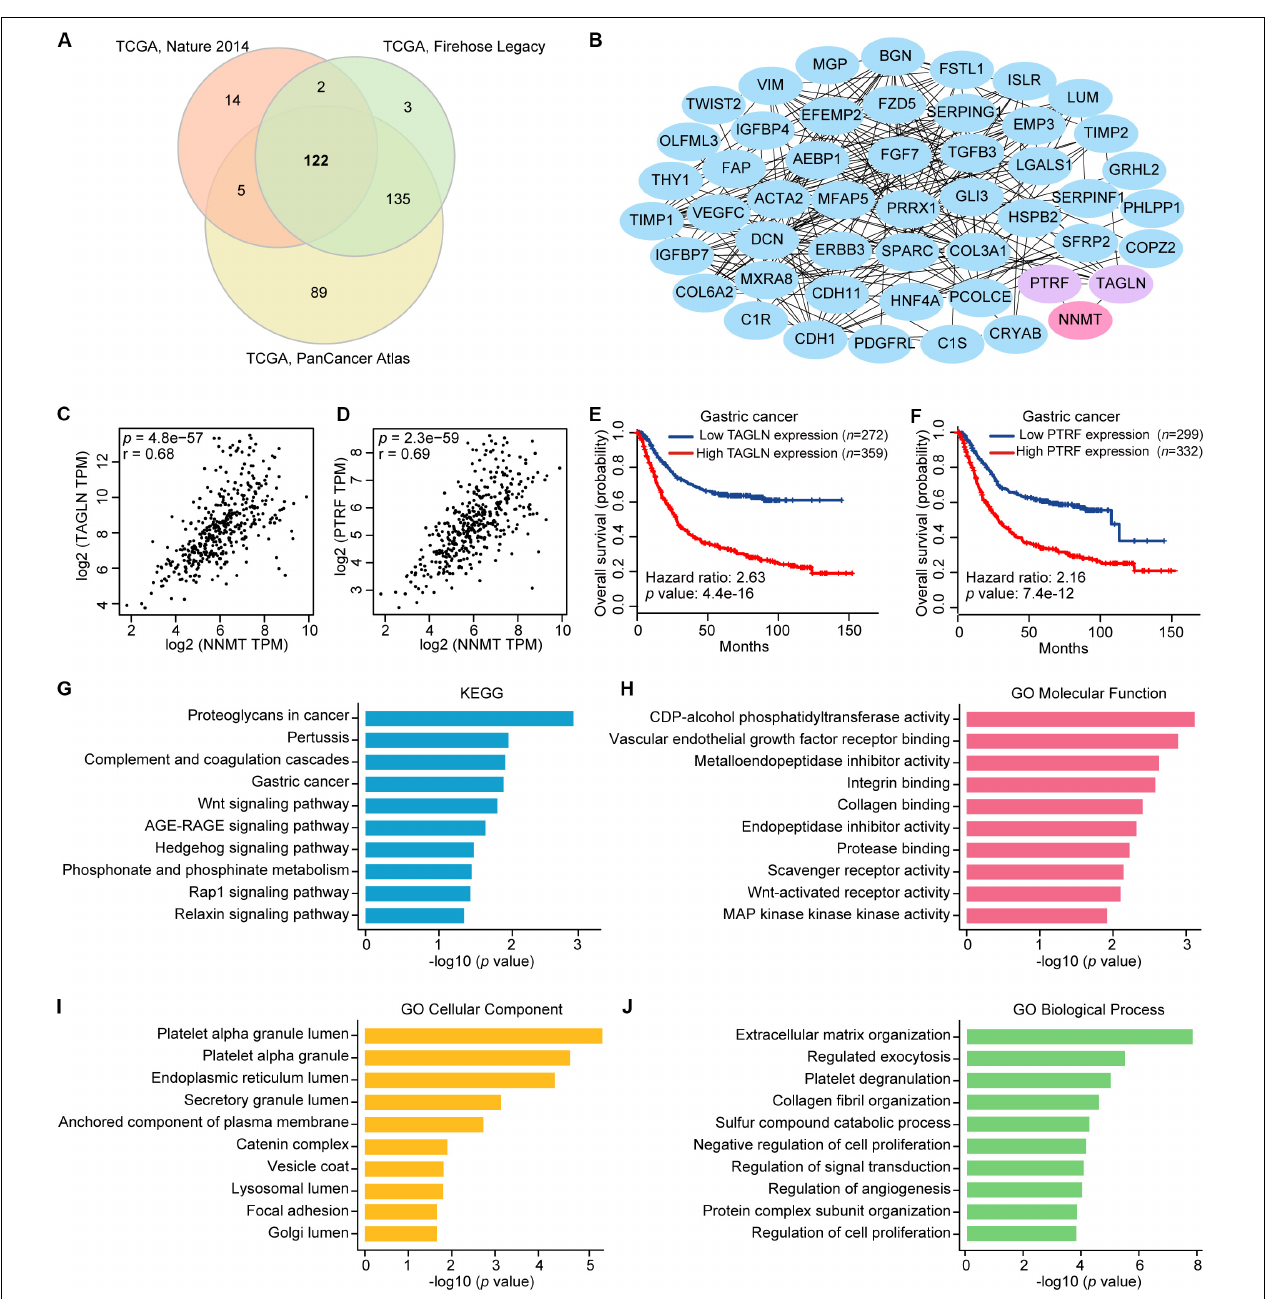
FIGURE 2 | Identification, interaction analyses, and enrichment analysis of NNMT correlated genes in GC. (A) Overlap of genes correlated with NNMT expression in the three TCGA-STAD cohorts, including Nature 2014, Firehose Legacy, and PanCancer Atlas based on cBioPortal database. (B) The top 50 genes evaluated by connectivity degree in the PPI network of the 122 genes significantly correlated with NNMT expression. (C) Correlation between NNMT and TAGLN ( r = 0.68). (D) Correlation between NNMT and PTRF ( r = 0.69). (E) The prognostic values of TAGLN in gastric cancer patients (Kaplan-Meier plotter). (F) The prognostic values of PTRF in gastric cancer patients (Kaplan-Meier plotter). (G) Kyoto Encyclopedia of Genes and Genomes (KEGG) pathway enrichment of the 122 genes significantly correlated with NNMT expression. (H–J) Gene Ontology (GO) molecular function (H) , cellular components (I) , and biological processes (J) enriched for the 122 genes significantly correlated with NNMT